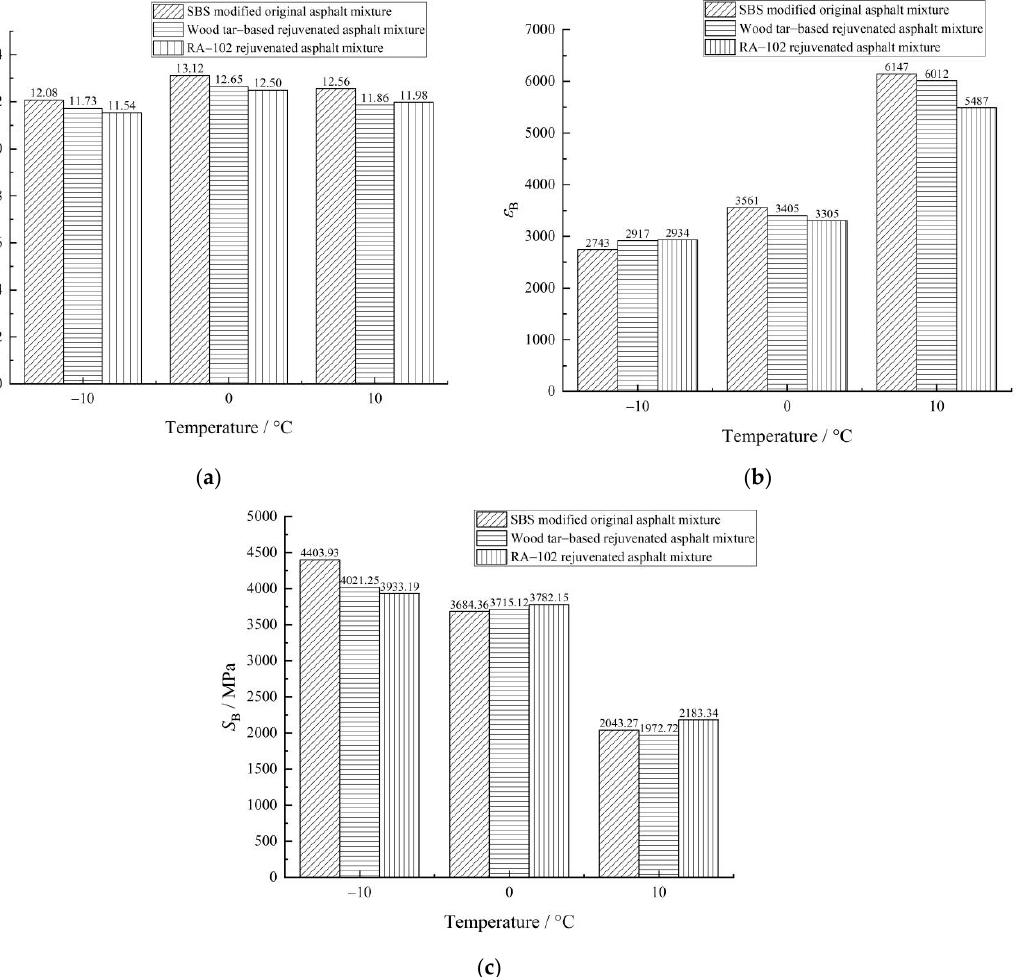
Figure 8. Trabecular bending test results of each asphalt mixture: ( a ) flexural tensile strength, ( b ) flexural tensile strain, and ( c ) stiffness modulus.